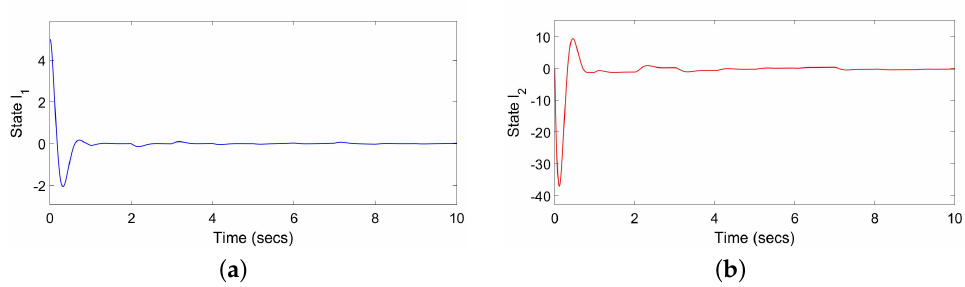
Figure 6. ( a ) State l 1 without probabilistic gain controller; ( b ) state l 2 without probabilistic gain controller.